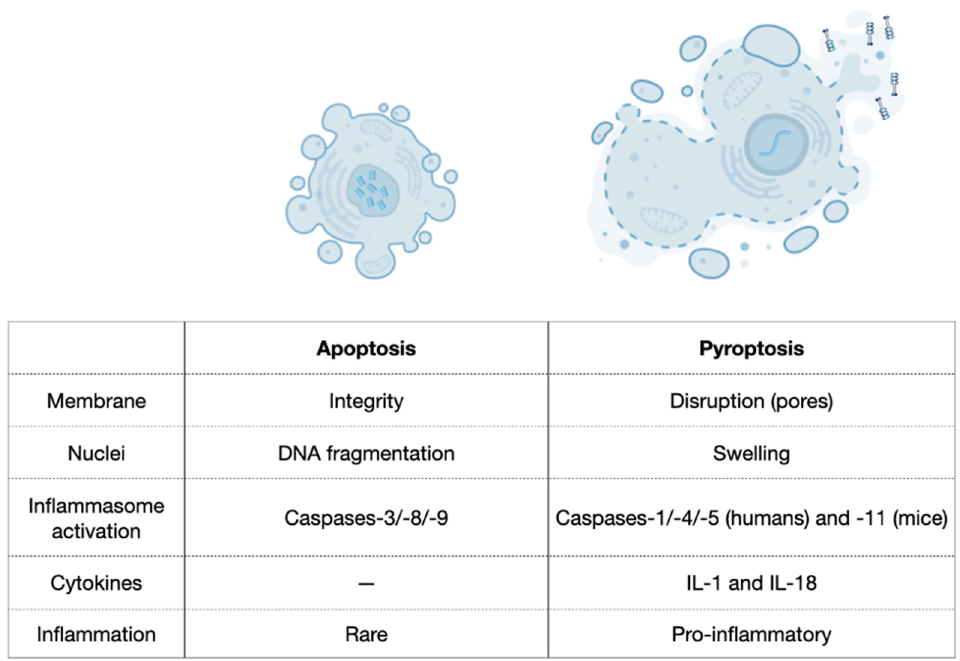
Figure 2. Comparison between apoptosis and pyroptosis. Based on Liu et al., 2018